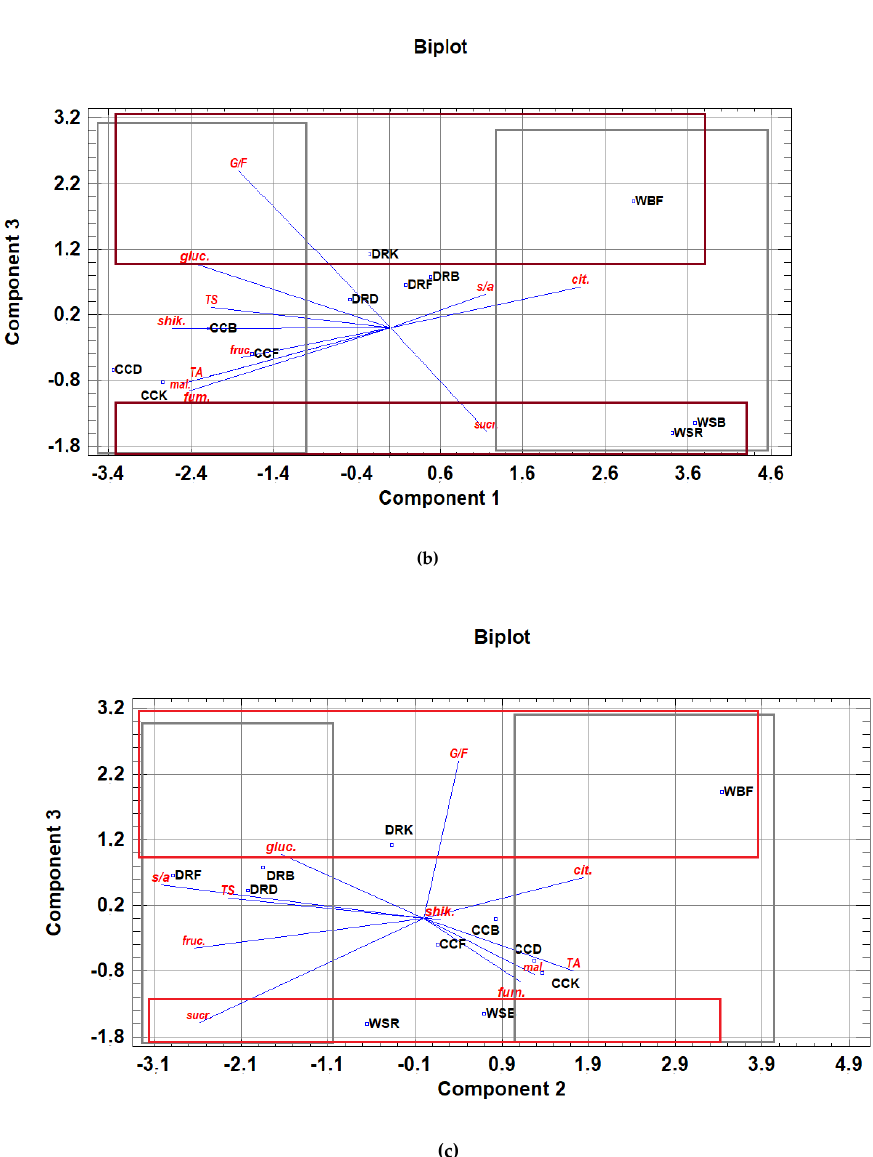
Figure 1. Principal component analysis (PCA) plots presenting graphical representation of the position of the analyzed wild fruit species from different growing regions (DRB, DRD, DRF, DRK—rosehip from Bugojno, Drvar, Foča and Konjic locations; CCB, CCD, CCF, CCK—cornelian cherry from Bugojno, Drvar, Foča and Konjic locations; WSR, WSB—wild strawberry from Romanija and Bjelašnica locations; WBF—wild bilberry from the Fojnica location) in relation to sugars (gluc—glucose; fruc—fructose; sucr—sucrose; TS—total sugars), organic acids (TA—total acids; mal—malic; cit—citric; shik—shikimic; fum—fumaric acid), glucose / fructose ratio (G / F) and sugar / acid ratio (s / a). ( a ) component 1 vs. component 2; ( b ) component 1 vs. component 3; ( c ) component 2 vs. component